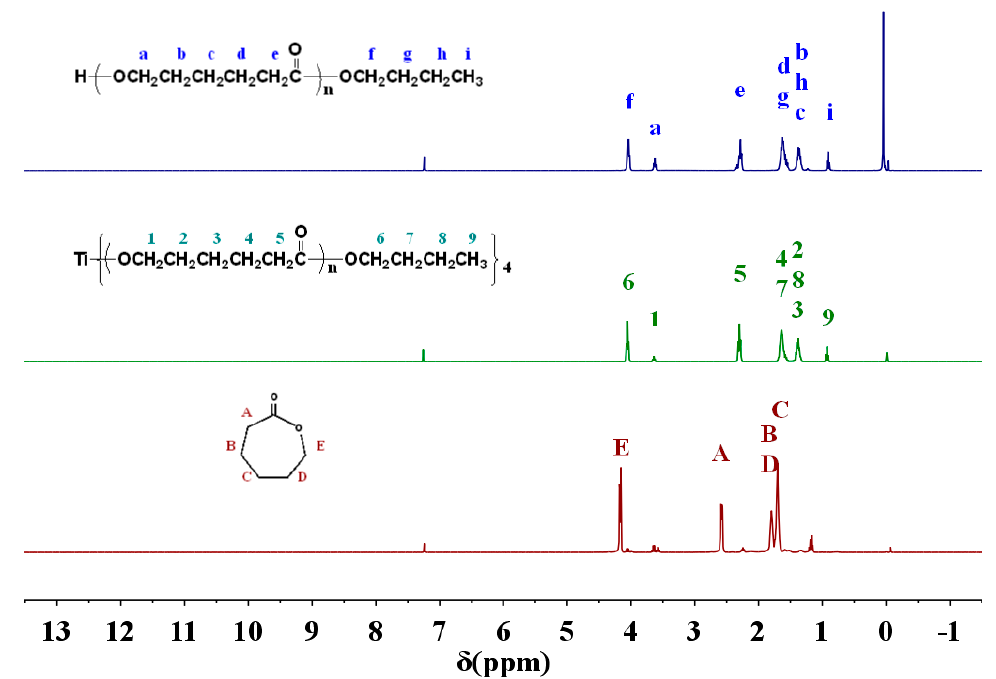
Figure 1. 1 H-NMR spectra of ε -CL, 4-PCL and